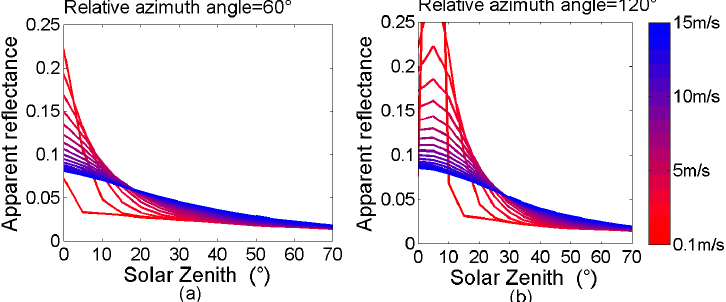
Figure 11. TOA (Top Of the atmosphere) reflectance (630–690 nm) varying with solar zenith angle and